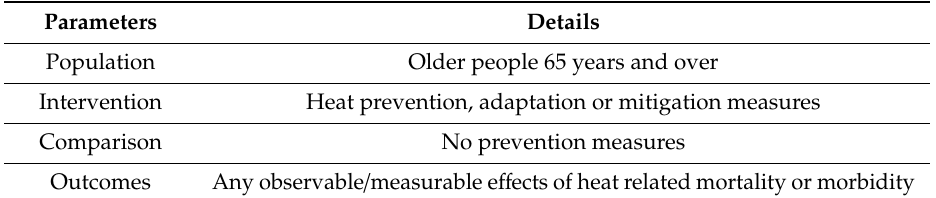
Table 1. The PICO